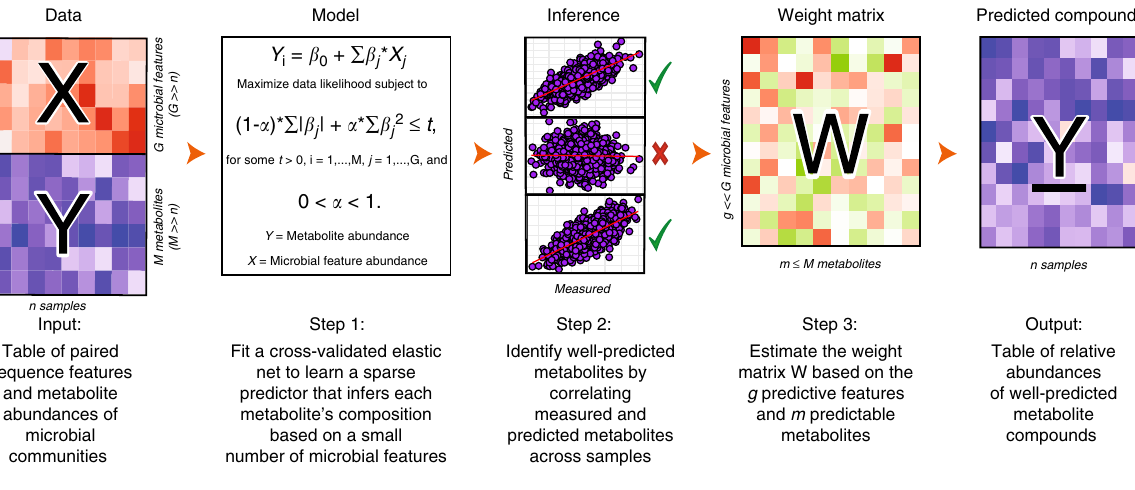
based on a small number of microbial features